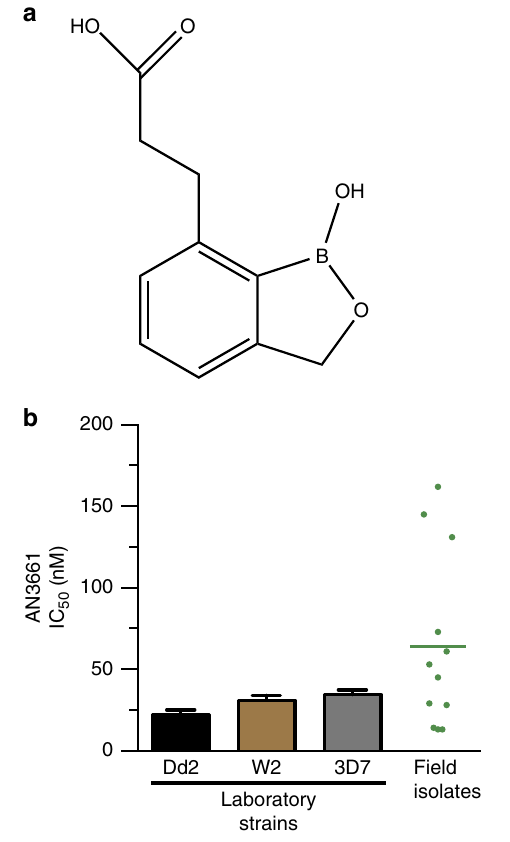
Figure 1 | Activity of AN3661 against P. falciparum laboratory-adapted strains and field isolates. ( a ) Chemical structure of AN3661. ( b ) Susceptibility of laboratory strains and field isolates to AN3661. Bar graphs represent mean ± s.e.m. IC 50 values. Each point in the dot plot represents one field isolate; the horizontal bar indicates the mean value.